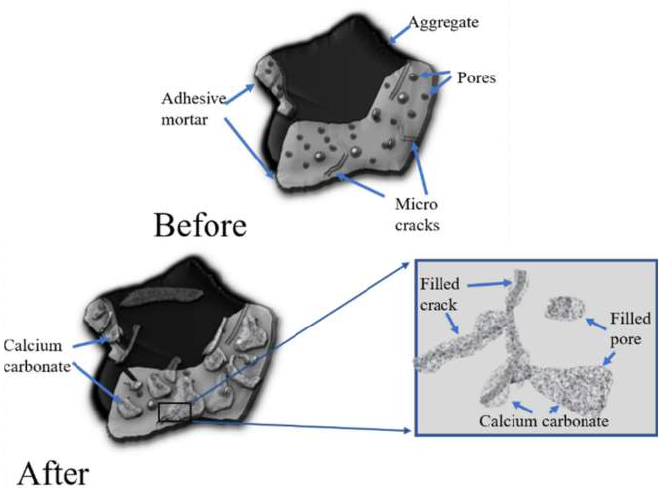
Figure 24. RA improved by biodeposition of calcium carbonate [9]. Reproduced with permission from [9], MDPI, 2021.